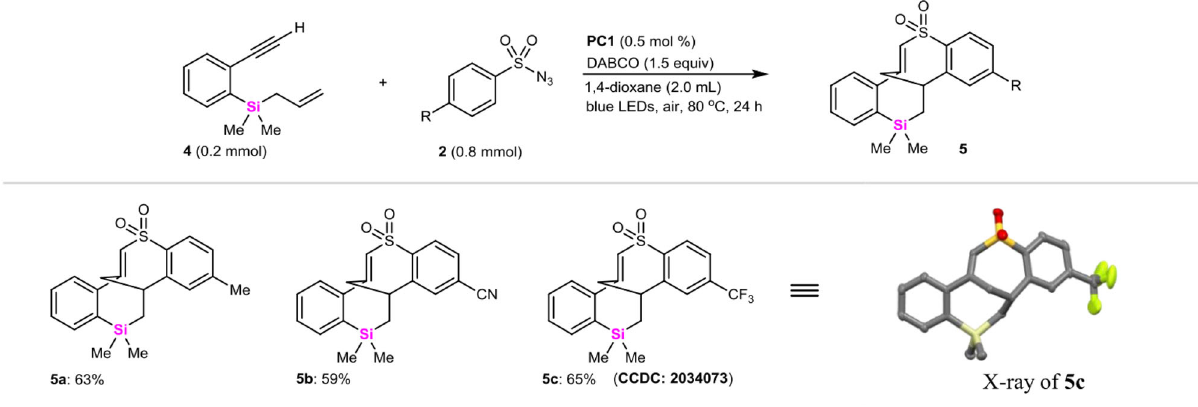
Fig. 4 The coupling-cyclization of allylic dimethylsilanes with arylsulfonyl azides. All the reactions are conducted in sealed tubes, followed by fl ash chromatography on SiO 2 . The isolated yields are